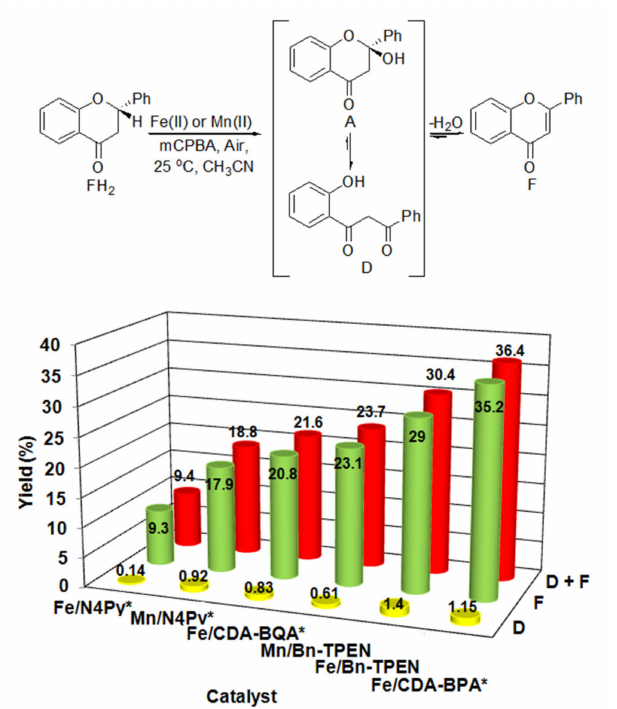
Figure 3. Comparison of the flavones-synthase activity of iron(II) and manganese(II) complexes. Conditions: [M II ] = 5 mM, [FH 2 ] = 100 mM and [ m CPBA] = 500 mM in CH 3 CN at 25 ◦